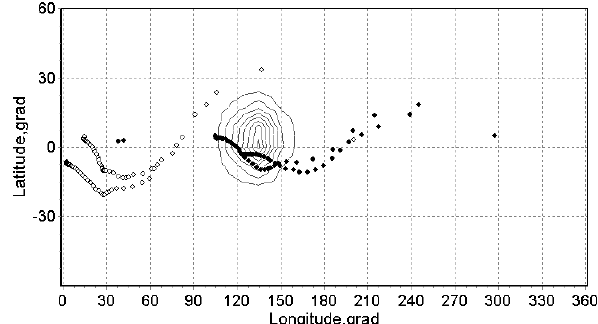
Location of the solar CR anisotropy source at 03:40– 03:50 UT (isometric curves of the equal fluxes) and asymptotic di- rections of vertical incident particles with energy < 15GeV for two stations (Gottingen and Leeds) with maximal effect (black points) and two stations (Ottawa and Chicago) with zero effect at this time (opened